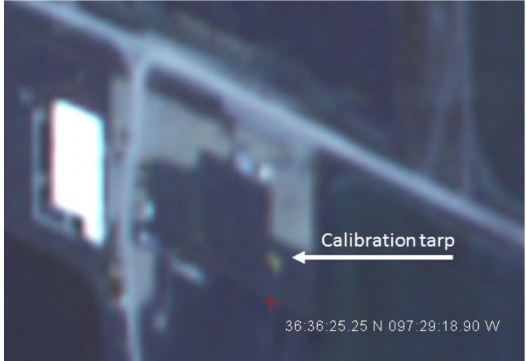
Figure 2. Blue tarp seen in WorldView-3 imagery used for calibration.